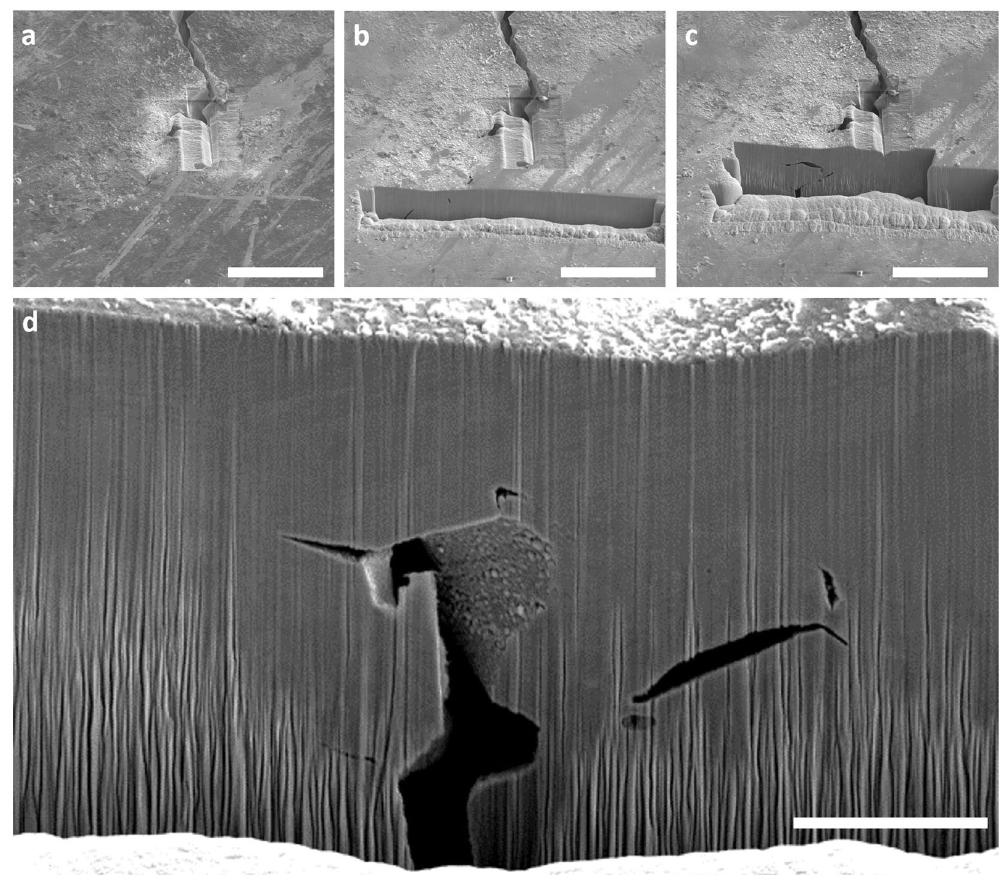
Fig. 6 Ex situ FIB milling showing subsurface IGSCC. ( a ) – ( d ) show secondary electron images collected as a part of a series of FIB slices into the area ahead of a crack tip, in the same region as that analysed by APT ( a – c ) scale bars: 50 µm, ( d ) scale bar: 10 µm). All images were collected at a tilt of 52° relative to the electron beam. Additional secondary electron images showing intermediate FIB cuts are given in Supplementary Fig.